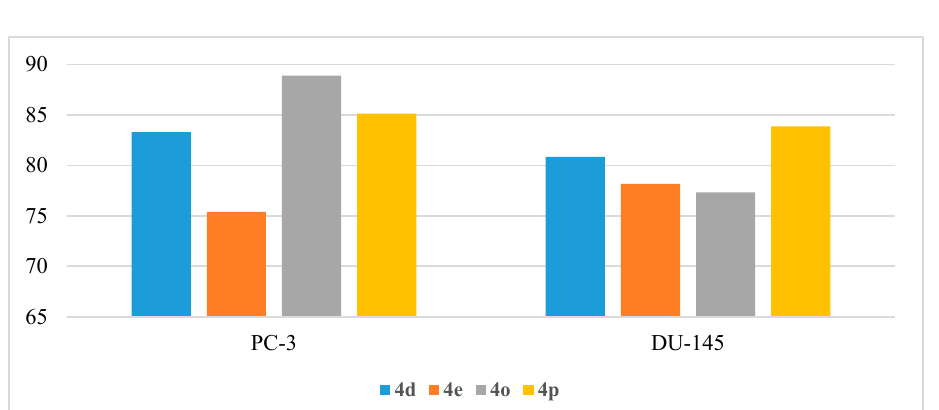
Figure 12. Anti-proliferative activities (% GI) of compounds 4d , 4e , 4o , and 4p against prostate cancer cell lines.